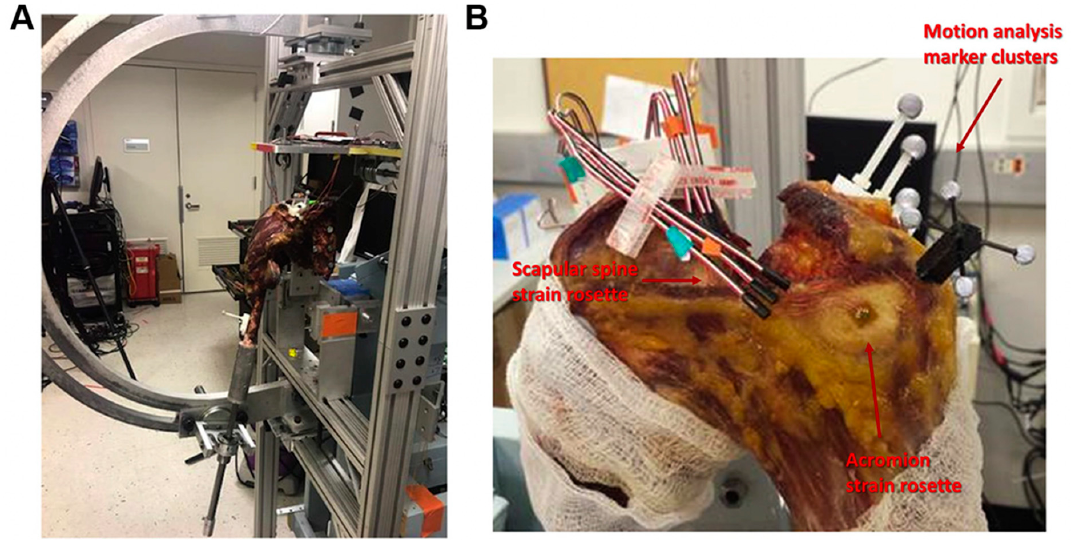
Figure 4. Biomechanical set up of the study by Shah et al. [29]. Reprinted with permission from ref. [29]. Copyright 2020 Elsevier. Biomechanical testing apparatus. ( A ) The humerus was mounted to a 6-degree-of-freedom shoulder simulator that can simulate different levels of abduction. ( B ) Strain rosettes (Vishay Measurements Group), 3 strain gauges overlapping and patterned in a 90 angle, were rigidly glued on to the surface of the acromial body and the scapular spine to represent the locations of Levy et al. [20] type II and type III fractures,